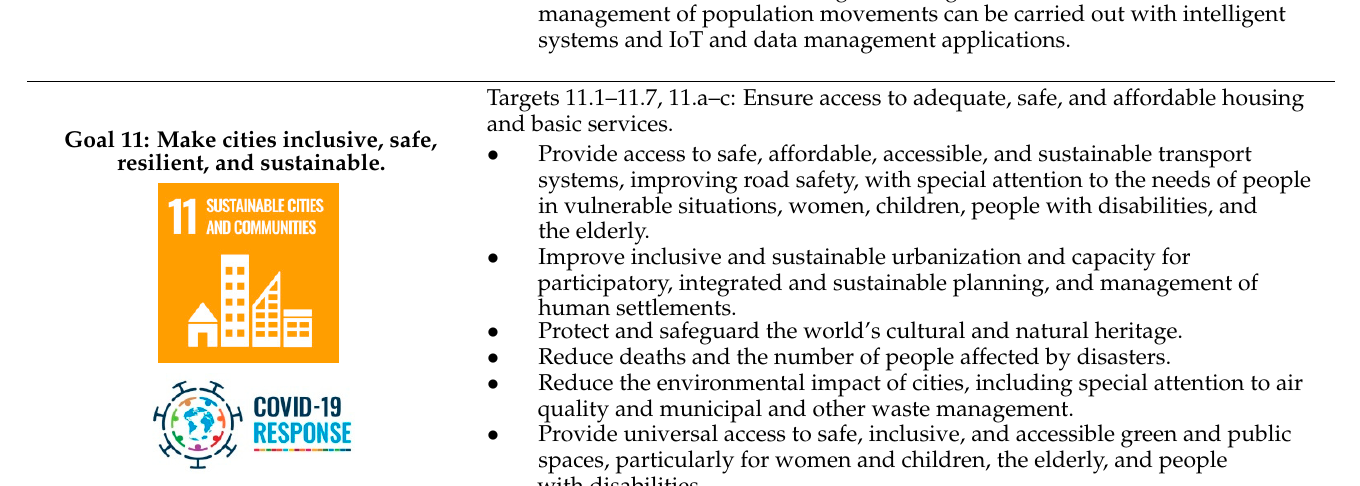
Table 5. Impact of the Sustainable Development Goals on IoT applications for improving health and the environment. SDGs Targets Goals and Application to IoT Systems